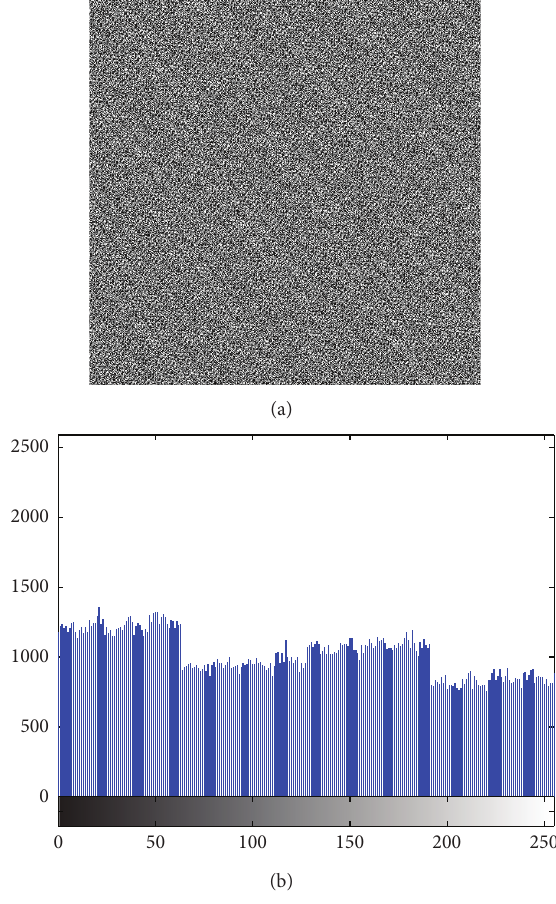
Figure 6: (a) Plain image after four rounds of bit permutation based on Zhu’s algorithm and (b) its